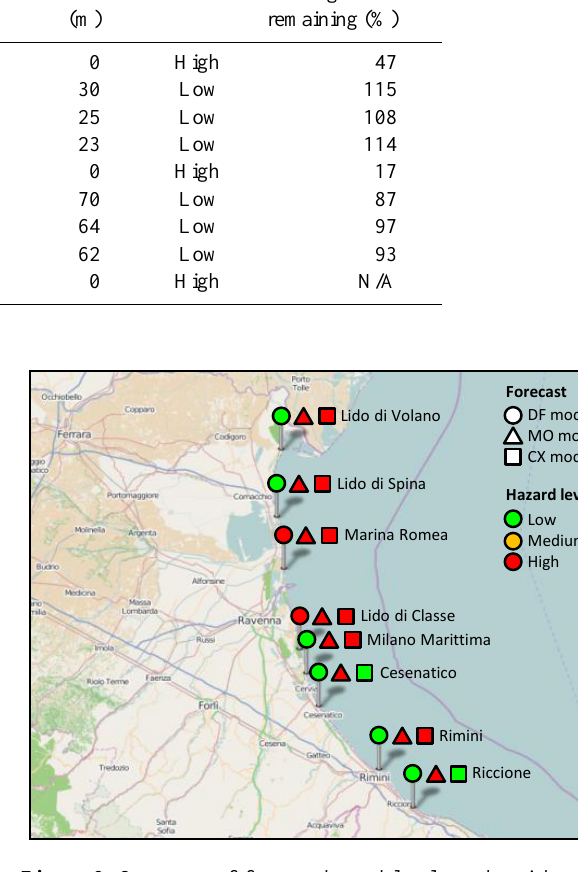
Figure 9. Summary of forecast hazard levels at the eight early- warning system sites for the three different reanalysis